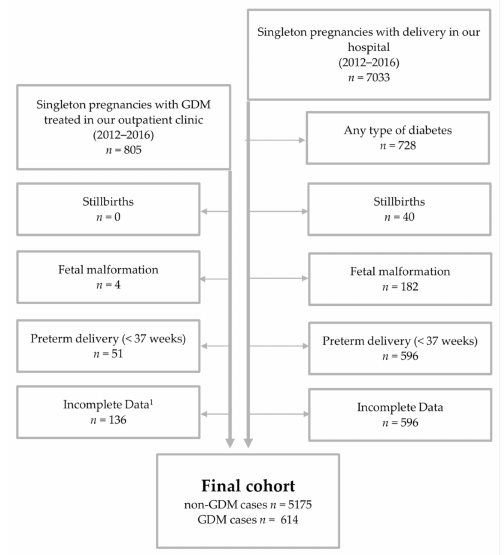
Figure 1. Cohort composition: The final cohort consists out of 614 gestational diabetes (GDM) cases and 5175 non-GDM term deliveries. The non-GDM cohort was derived from initially 7033 singleton mother infant dyads from 2012 until 2016. All cases of stillbirths, fetal malformations, preterm deliveries (<37 weeks) and cases with incomplete data were excluded in both groups. All types of diabetes cases were excluded in the non-GDM group. 1 Higher rate of exclusions due to missing information about deliveries ex